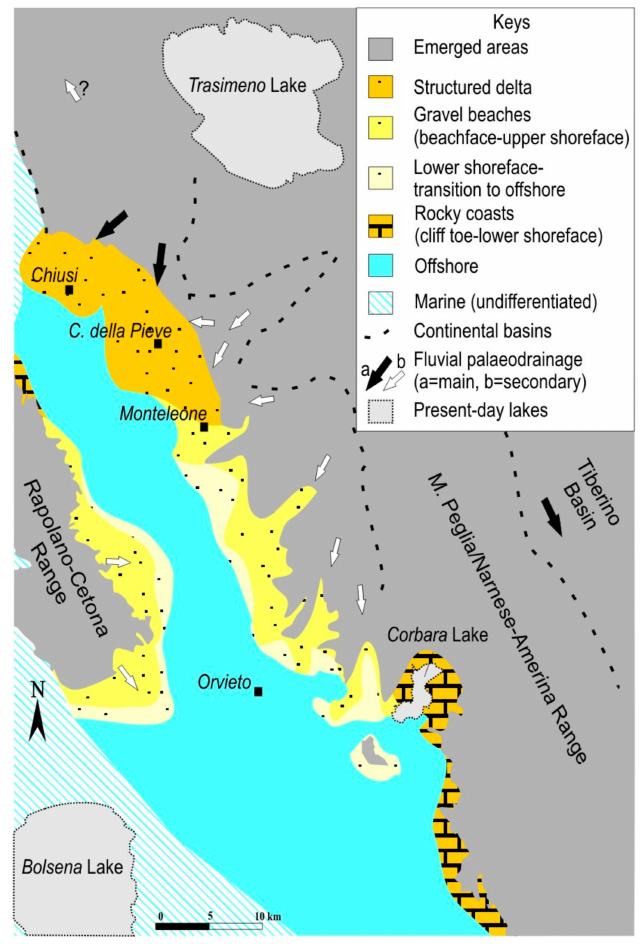
Figure 4. Paleogeographic and paleoenvironmental reconstruction of the study area during the early